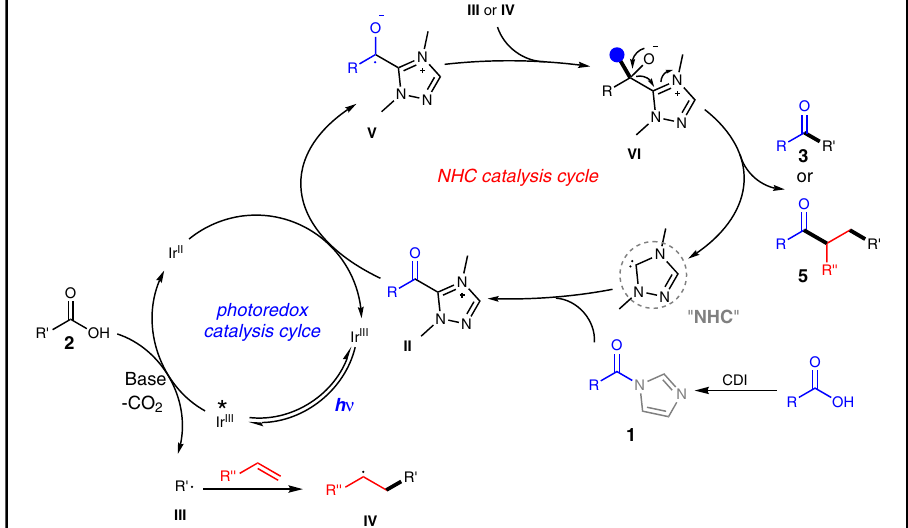
Fig. 7 Proposed catalytic cycle. NHC and photocatalyst co-catalyzed